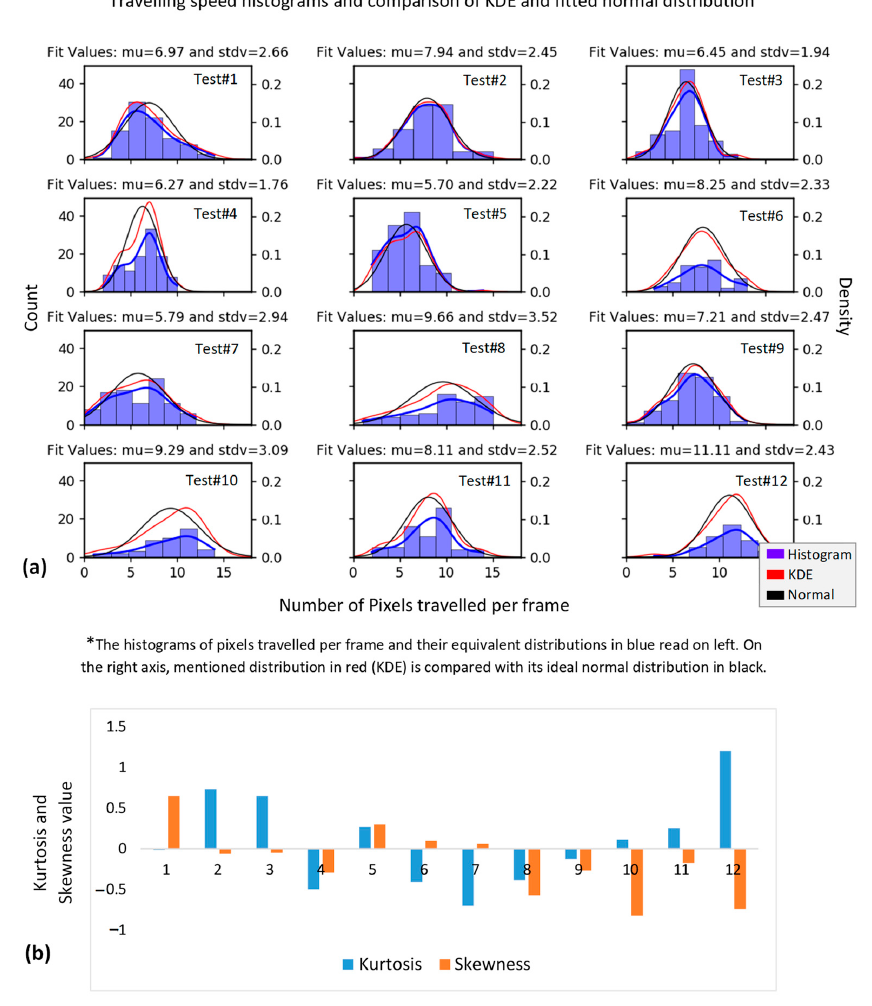
Figure 5. Statistical parameters representing the uniformity and consistency of the carrier speed. ( a ) Shows the histogram of test speeds and their equivalent distributions for 12 tests and ( b ) represents Kurtosis and Skewness values calculated from each distribution.